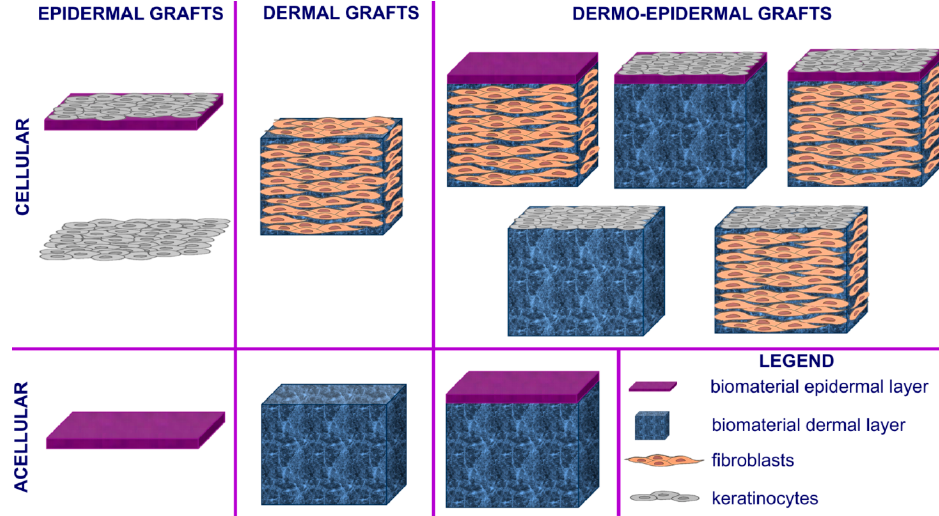
Figure 3. Different variants of tissue-engineered artificial skin grafts. Figure 3. Di ff erent variants of tissue-engineered artificial skin grafts.